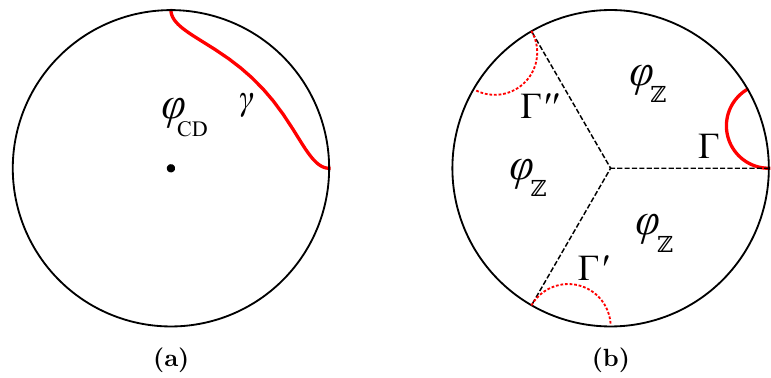
Figure 7 . (a) A conical defect (cid:12)eld integrated over a geodesic (cid:13) is the same as (b) a symmetrized AdS 3 (cid:12)eld integrated over one of the preimages of (cid:13) under the Z N quotient. Identifying the edges of any wedge gives the conical defect of